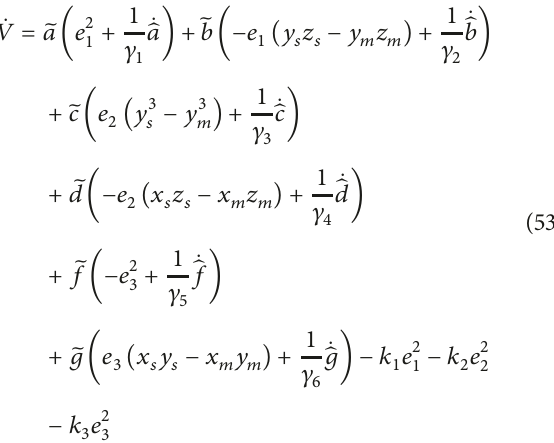
By substituting (49) into (52), and after accomplishing the corresponding operations and grouping like terms, the fol- lowing is